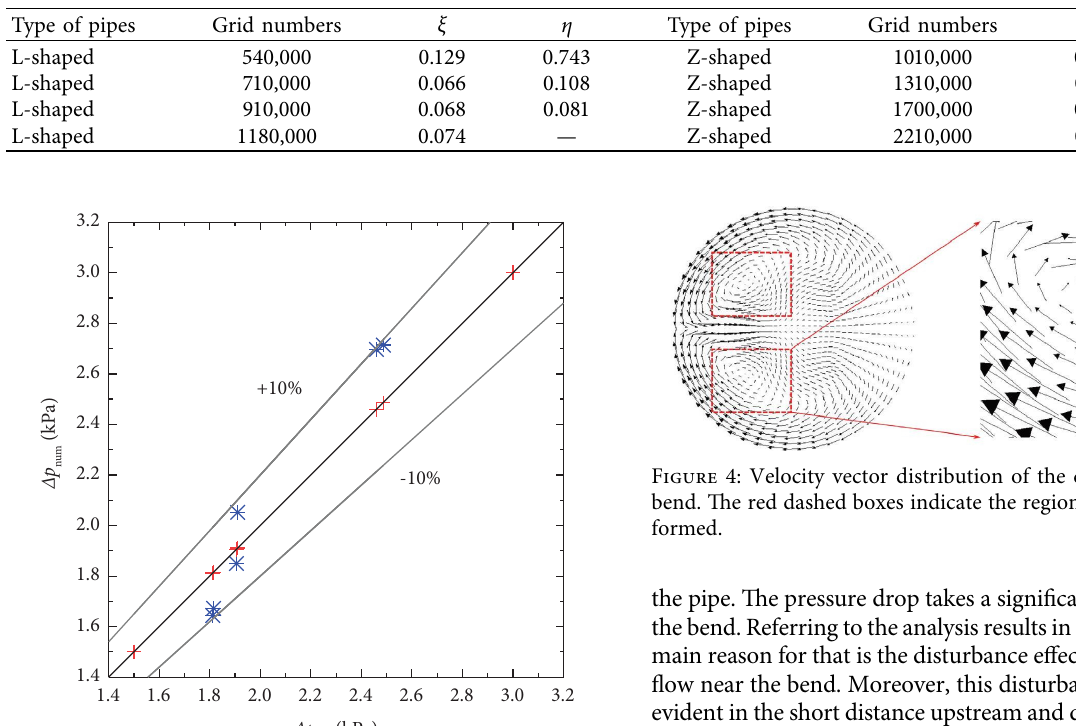
Table 1: Results of grid-independence